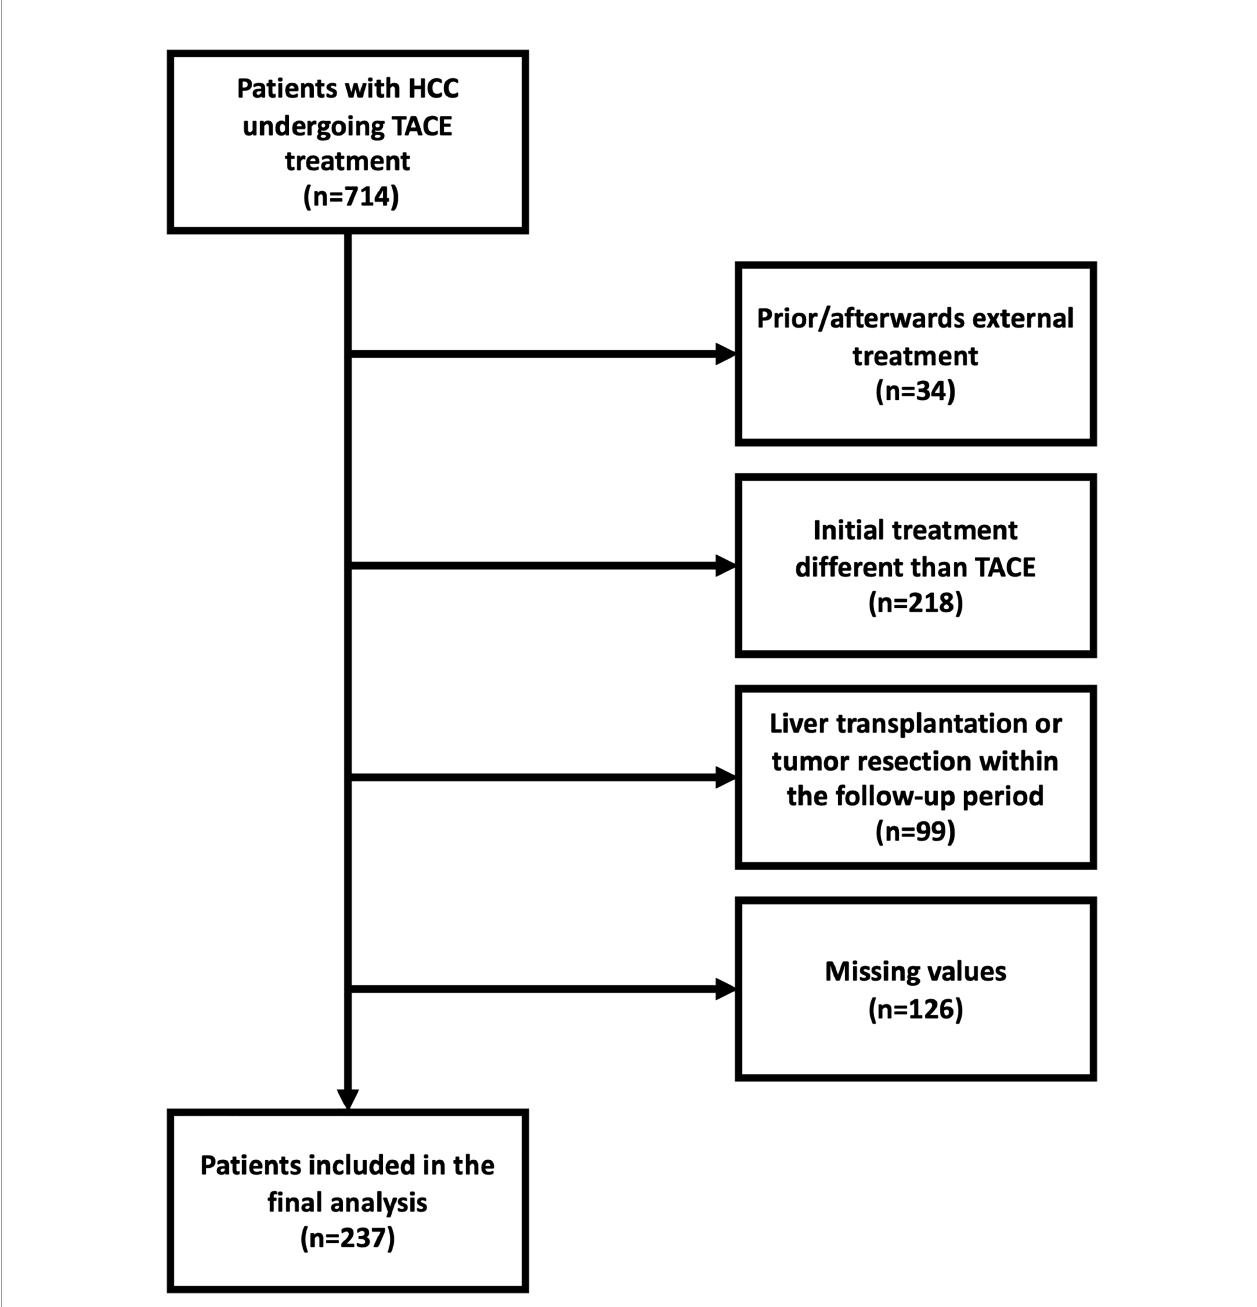
FIGURE 1 | Flowchart providing the reasons for dropouts and the fi nal number of patients for whom the PNI and CONUT score could be evaluated. HCC, hepatocellular carcinoma; TACE, transarterial